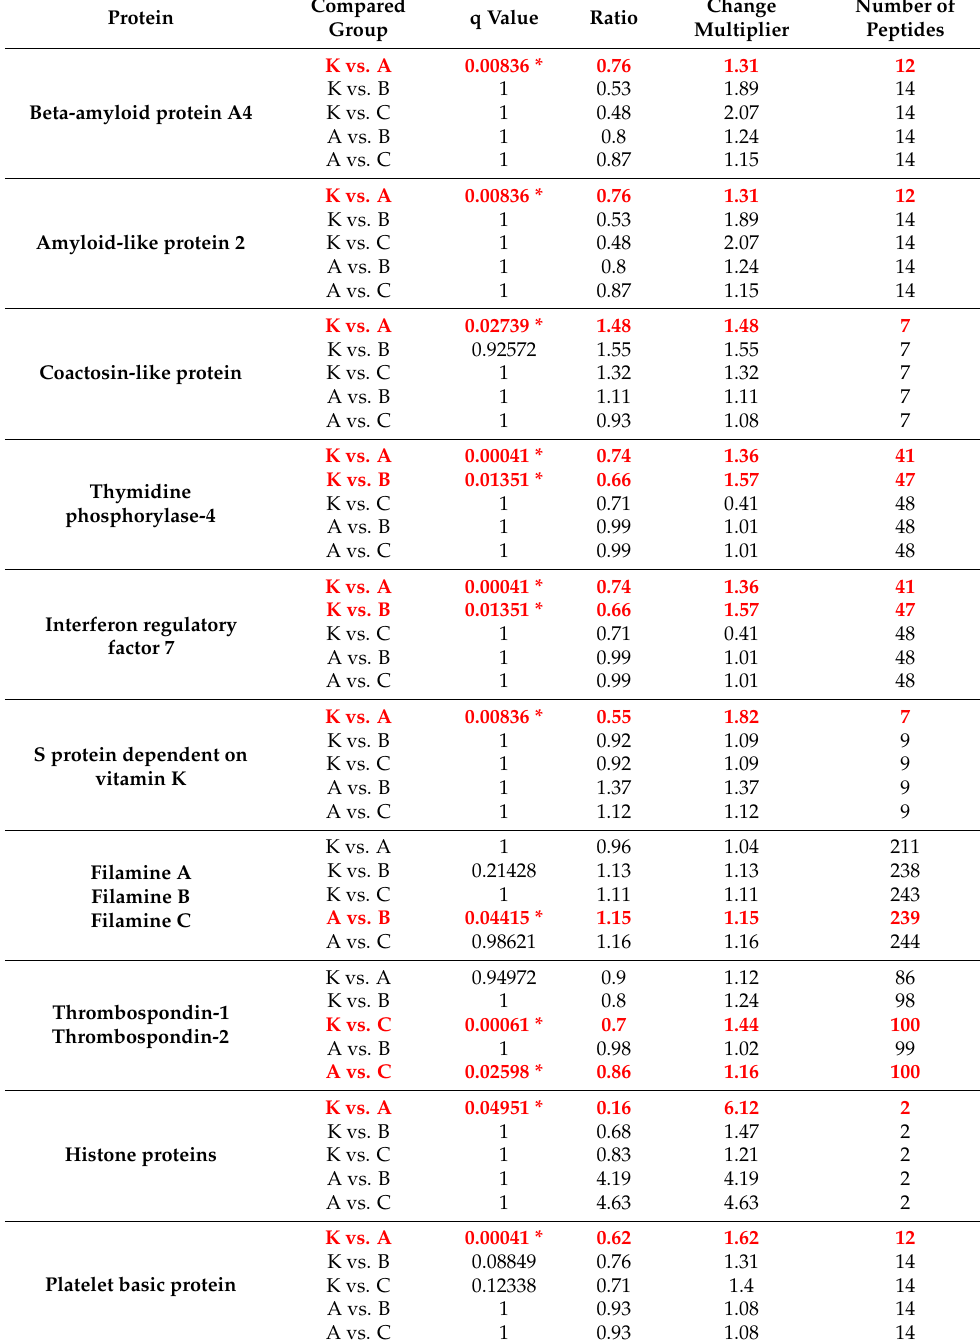
Table 2. Comparison of the platelet proteins differing between the stroke (A, B, and C) vs. control group (K) as well as within the stroke subjects in the defined time intervals (A vs. B and A vs. C). Compared Protein q Value Group